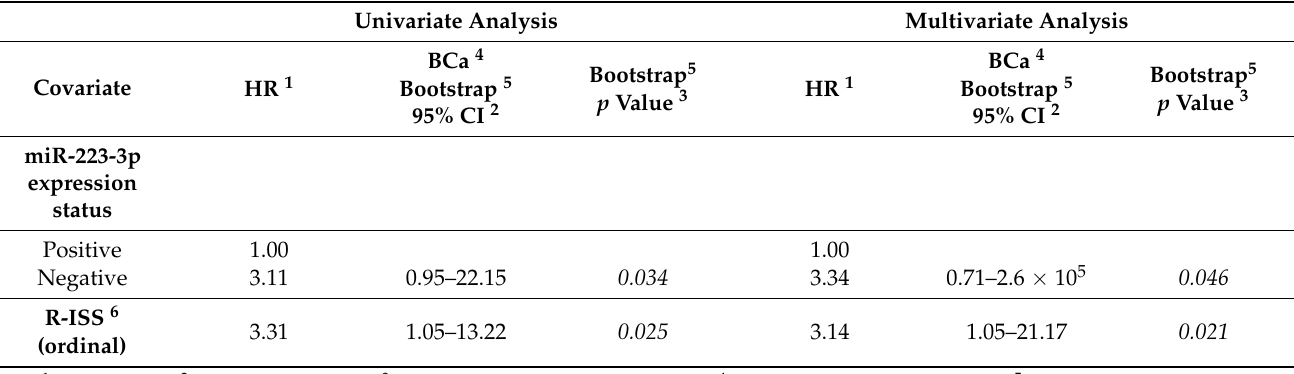
Table 2. Univariate and multivariate Cox regression analyses, regarding MM patients’ overall survival (OS).